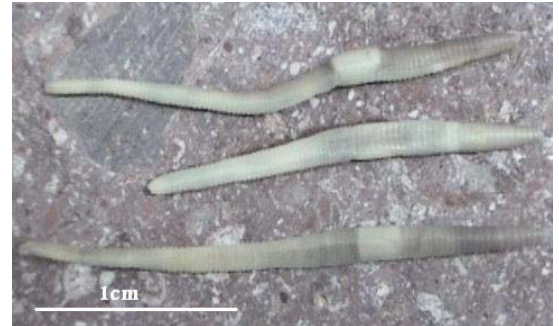
F IGURE 4. Aporrectodea rosea. F IGURE 5. Dendrobaena veneta.